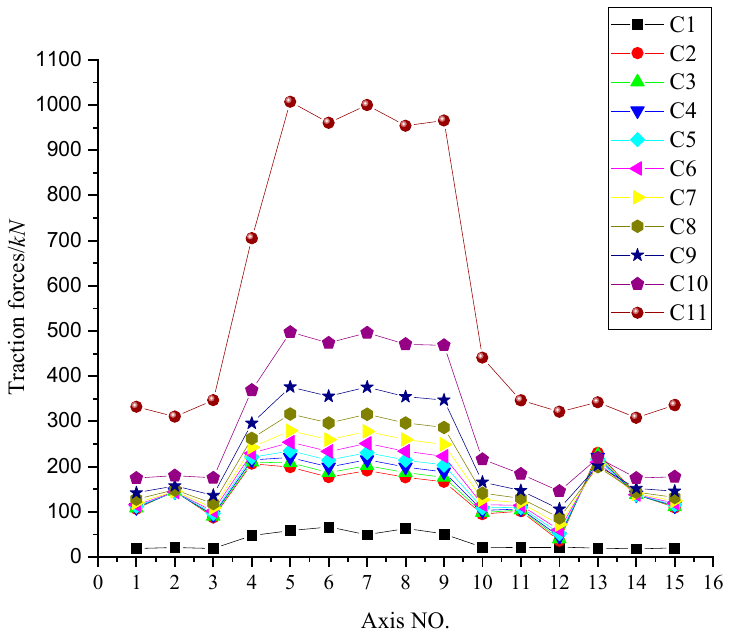
Figure 20: axis 1 (long axis), axis 6 and 8 (45 ◦ ), and axis 15 (short axis). The changes in internal force under traction conditions are also drawn as variation curves, as shown in Figures 21 and